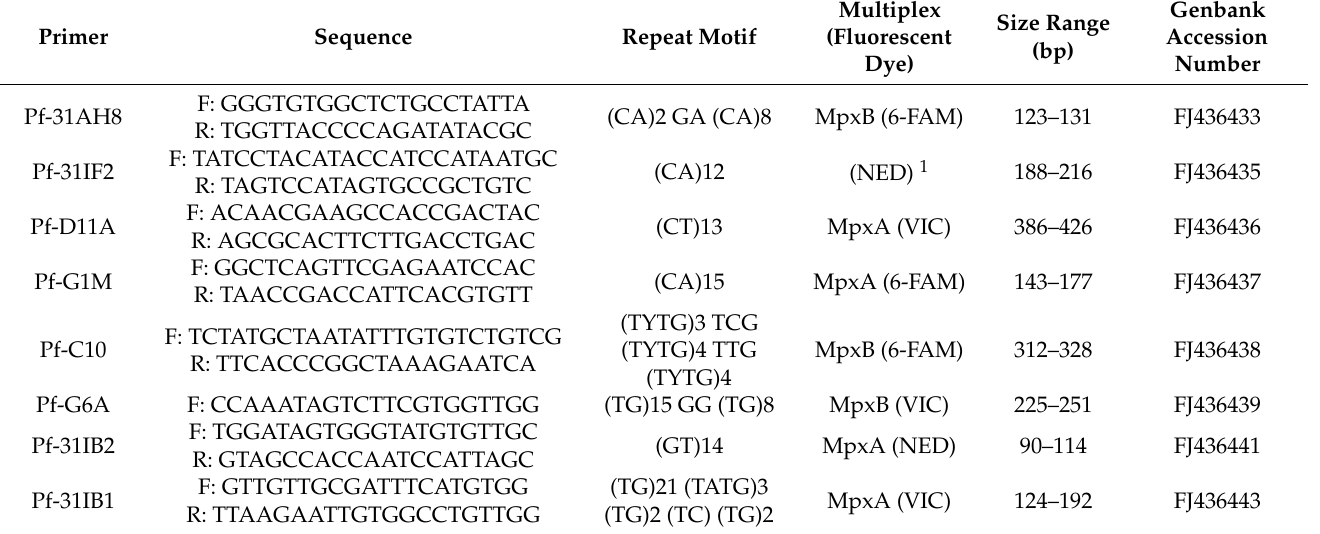
Table 1. Characteristics of the microsatellite loci used in the present study. F = Forward sequence; R= reverse sequence; bp = base pairs. See Table S2 for protocol